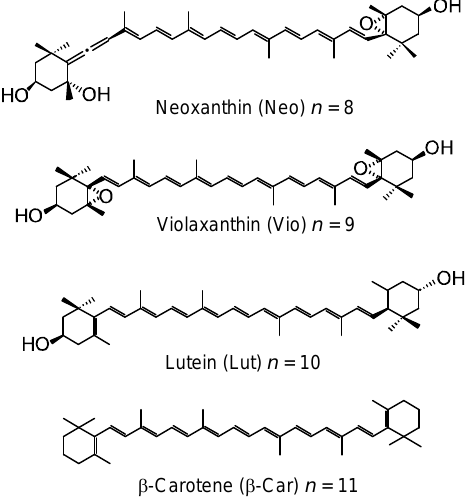
Figure 24. Chemical structures of plant Cars with n =